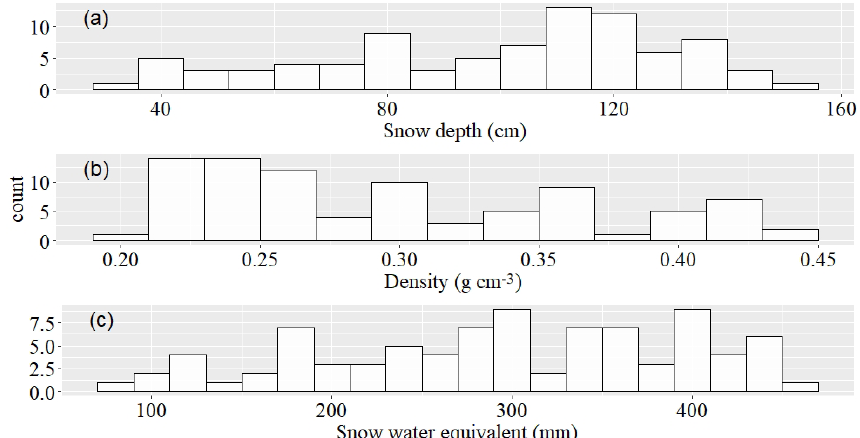
Figure 2. Distribution of (a) mean snow depth, (b) mean snow density, and (c) mean snow water equivalent on the NEIGE site for 2016–2020 field measurements.